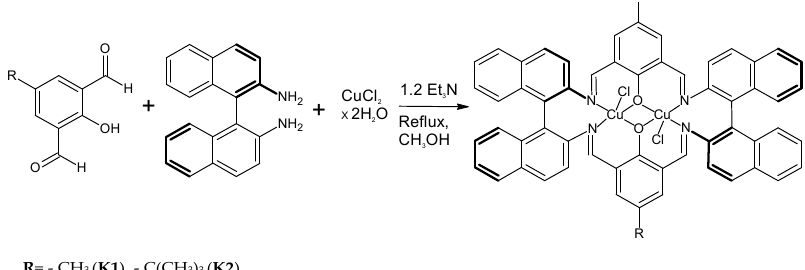
Figure 1. Scheme of the copper(II) complex K1 and K2 synthesis.